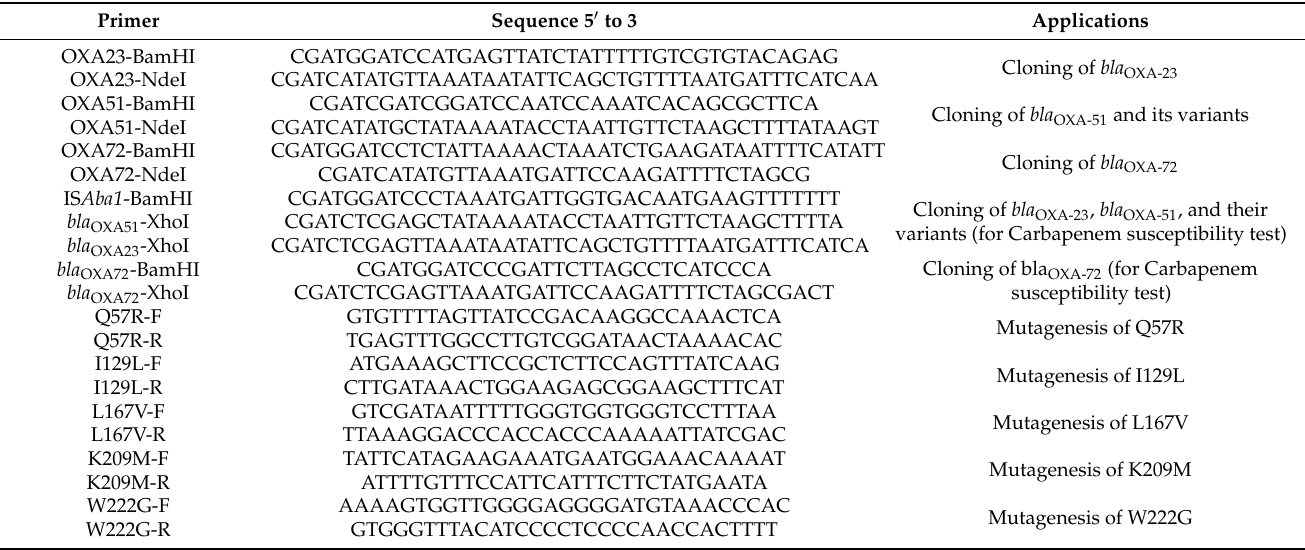
Table 1. Primers used in this